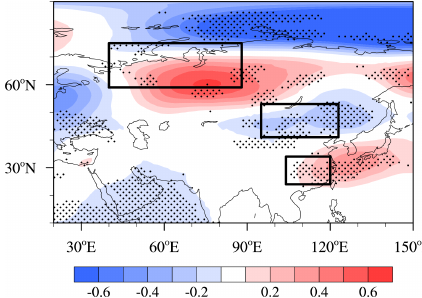
Figure 7. Composite differences of geopotential height at 500hPa in JJA between three low- and high-SI FJL years based on the ensem- ble of 40 CESM-LE simulations during 1980–2019. The black dots indicate that the mathematical sign of the composite results of more than 60% of the members is consistent with the ensemble mean. The black boxes represent the centers of the EU-like